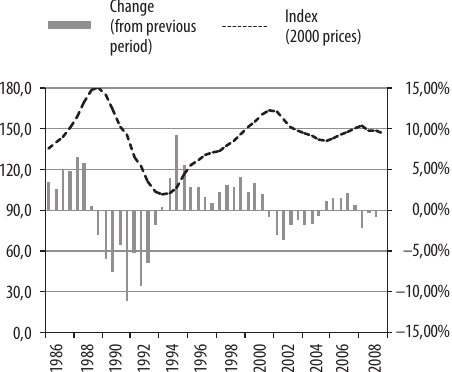
Fig. 2. Deflated Helsinki CBD rental index and its period-over-period change (index data: